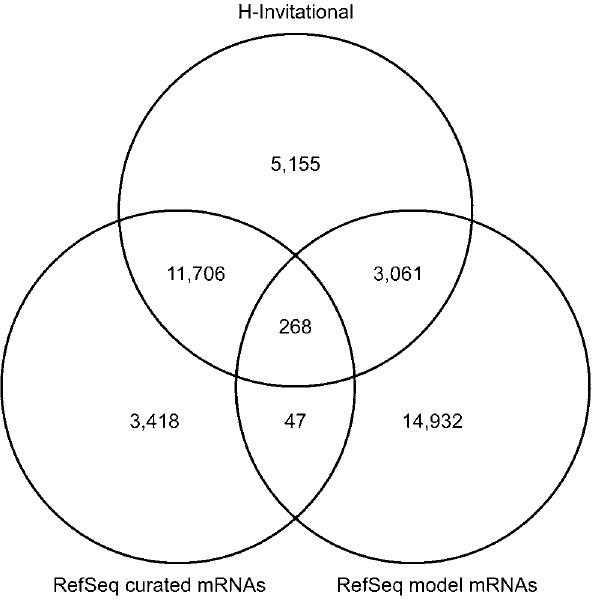
Figure 2. A Comparison of the Mapped H-Inv FLcDNAs and the RefSeq mRNAs The mapped H-Inv cDNAs, the RefSeq curated mRNAs (accession prefixes NM and NR), and the RefSeq model mRNAs (accession prefixes XM and XR) provided by the genome annotation process were clustered based on the genome position. The numbers of loci that were identified by clustering are shown. DOI: